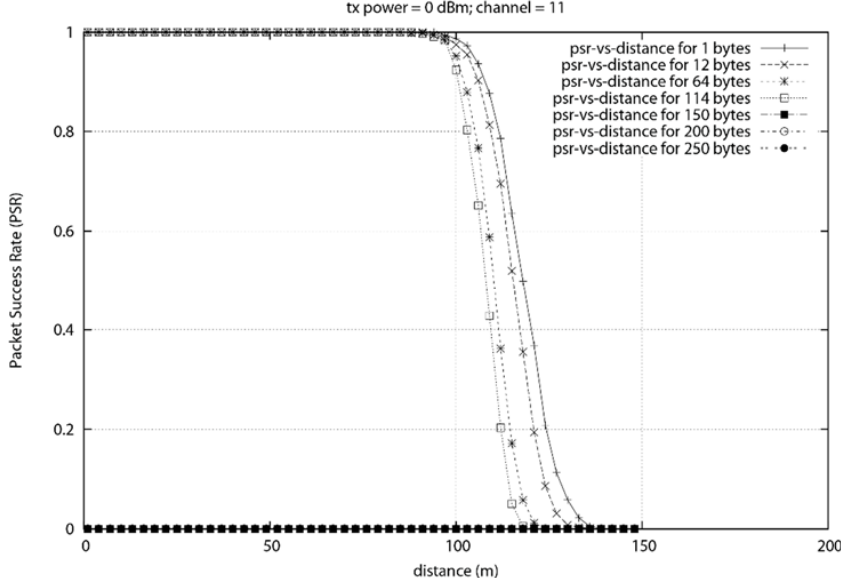
Figure 18 . PSR vs. Distance with different packet size. Figure 18. PSR vs. Distance with different packet